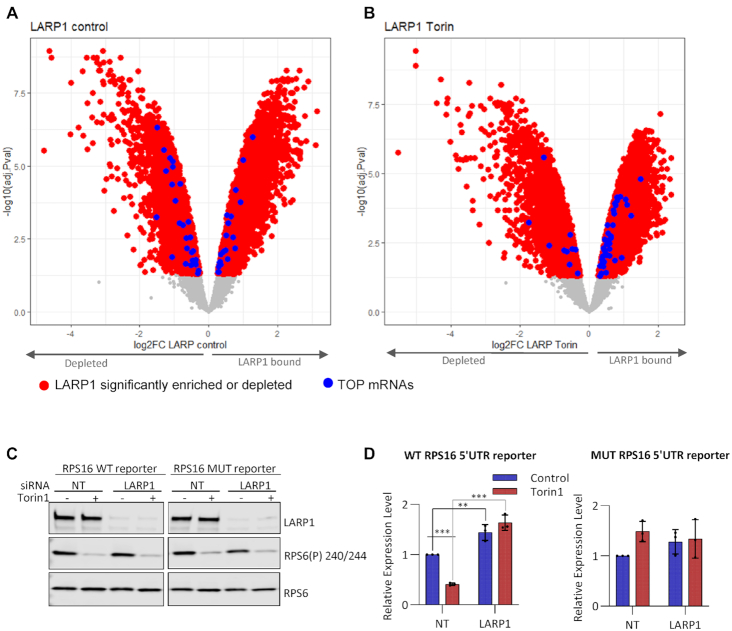
LARP1 binding to terminal oligopyrimidine tract containing mRNAs increases after mTOR inactivation. Log fold enrichment over input of all LARP1 bound mRNAs following immunoprecipitation from (A) Control treated or (B) Torin1 treated HeLa cells. mRNAs significantly (FDR < 0.05) enriched (LARP1 bound) or depleted over input shown in red, of these, blue data points represent TOP containing mRNAs as listed in (5). Non-significantly enriched mRNAs are in grey. C and D: HeLa cells transfected at a final concentration of 20 nM control or LARP1 siRNA were subsequently transfected with RPS16- PEST-CL reporters and control pRL-SV40 vector (Promega E2231). After 24 h, cells were treated with Torin1 or DMSO (control) for 2h followed by lysis. Experiment performed three times. (C) Western blots were performed using indicated antibodies. Representative western blots shown from one experiment of three. (D) Luciferase assays were performed in duplicate for each of 3 triplicate wells. Relative luciferase activity was calculated as a ratio of firefly luciferase to renilla luciferase. These were then normalized to firefly RNA levels to determine luciferase protein expression changes. The means and individual data points of three independent experiments are plotted with error bars indicating SD. Non-RNA normalized data is shown in Supplementary Figure S6.